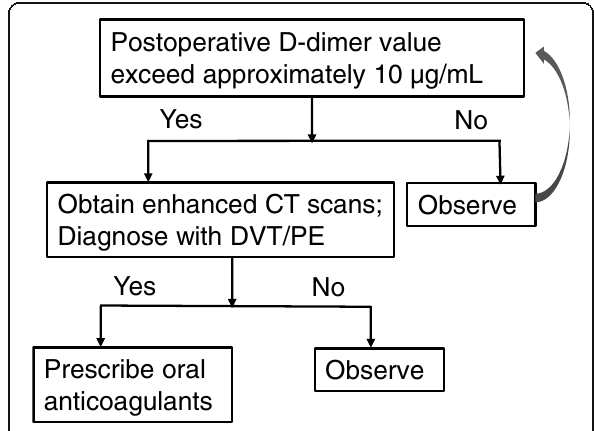
Fig. 1 Diagnosis flowchart of DVT/PE in our center. DVT/PE, deep venous thrombosis and pulmonary embolism; CT, computed